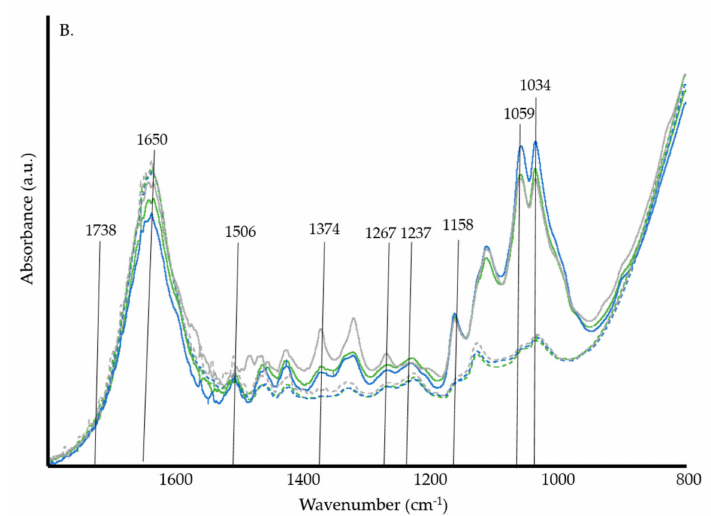
Figure 2. Mean ATR-FTIR spectra ( A ) before extraction for balsa sets A1 (yellow) and A2 (orange), oak sets B (red), C (purple), D1 (dark blue), D2, (light blue) and G2 (black), and pinewood sets E (dark green), F (light green) and G1 (gray), ( B ) after BT (green), CT (blue) or NT (gray) for oak sets B (fresh wood, —) and D1 (waterlogged wood, dashed line - -).